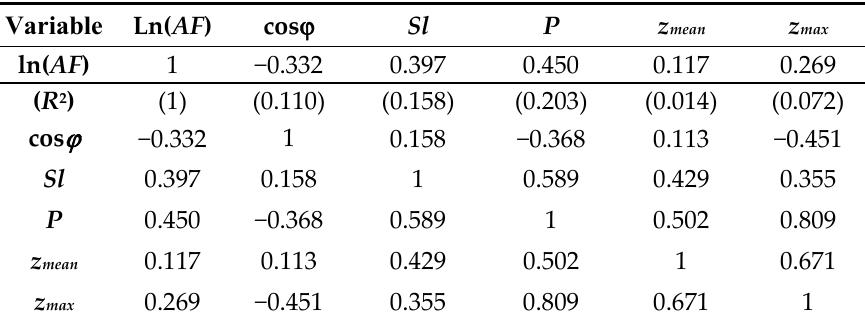
Table 5. Correlation